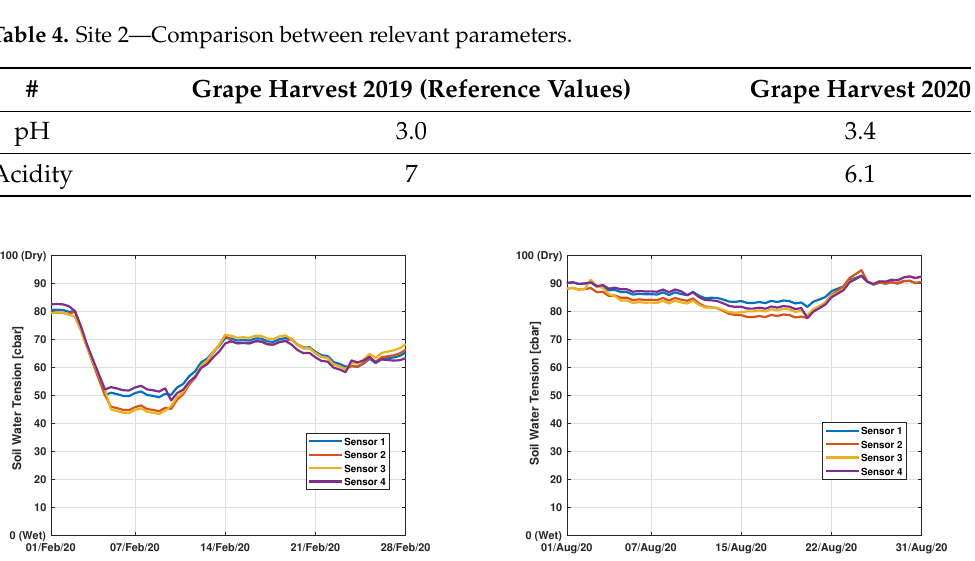
Figure 14. Site 1—Soil moisture averaged values: February 2020 ( left ) and August 2020 ( right ).